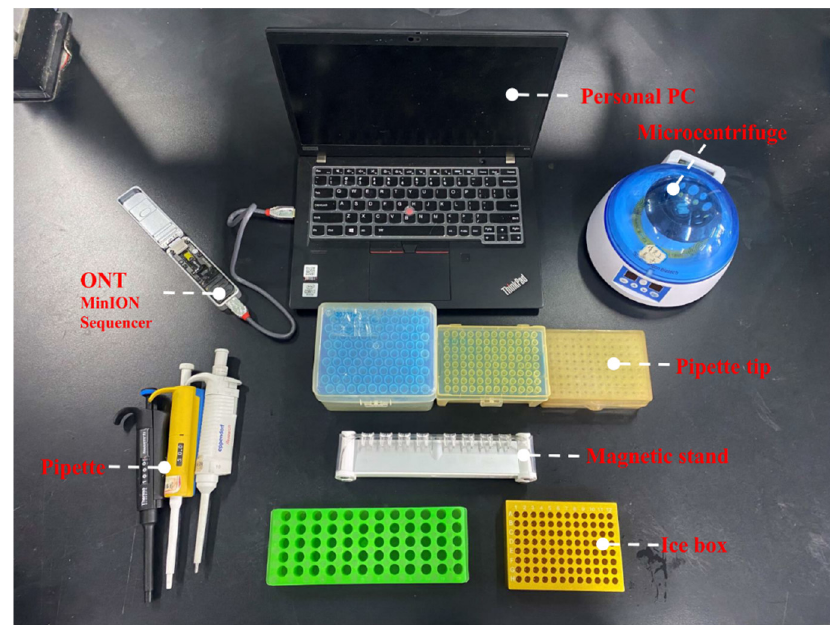
Figure 2. Equipment needed for rapid sequencing with the MinION sequencer.